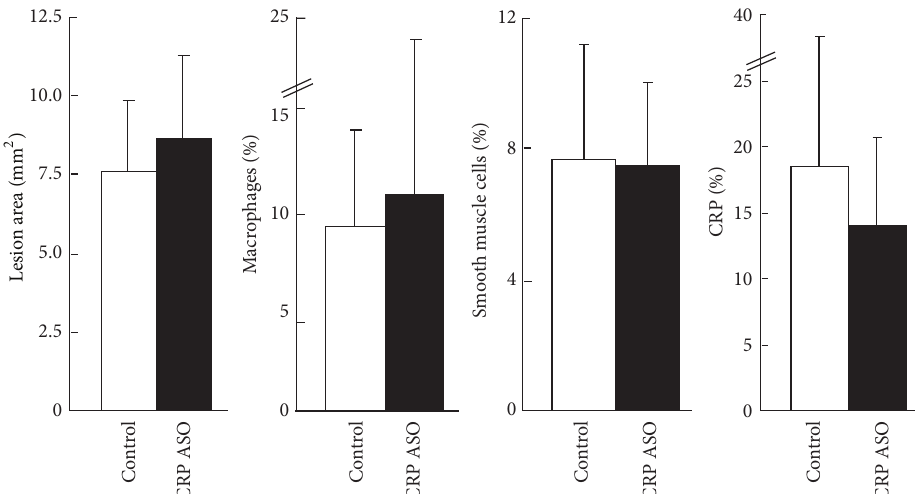
Figure9:Microscopicanalysisoftheaorticlesions.Serialparaffinsectionswerestainedwithhematoxylin-eosin(HE)andelasticavanGieson (EVG) or immunohistochemically stained with monoclonal antibodies (mAbs) against either macrophages (M 𝜑 ) or 𝛼 -smooth muscle actin for smooth muscle cells (SMC) or rabbit CRP. Intimal lesions on EVG-stained sections and positively immunostained areas of macrophages; SMC and CRP were quantified with an image analysis system. Data are combined from male and female rabbits and expressed as the mean ± SD. 𝑛 = 10 for each group.